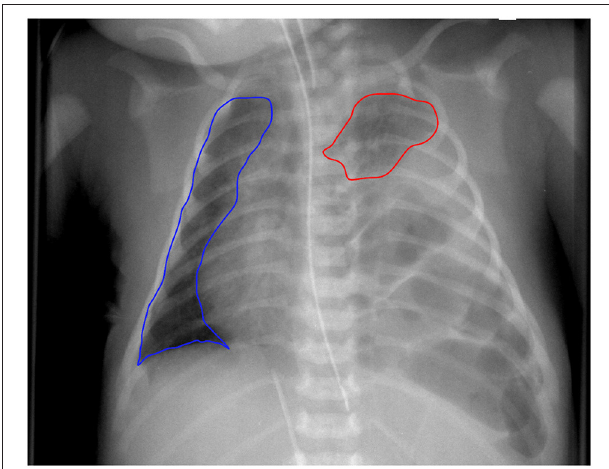
FIGURE 1 | Delineation of chest radiographic thoracic area. Example of a newborn with left-sided congenital diaphragmatic hernia. CRTA was calculated as the sum of area of ipsilateral and contralateral lung. Segmentation was performed manually.